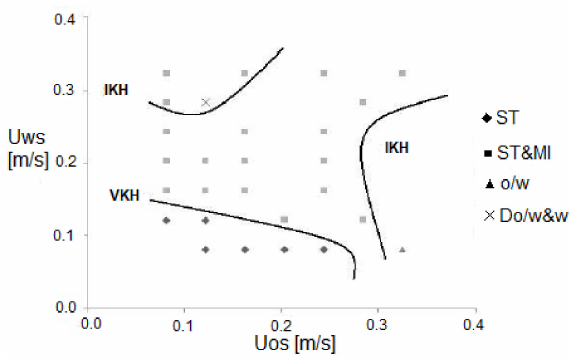
Figure 4. Flow map of the experiments [11]